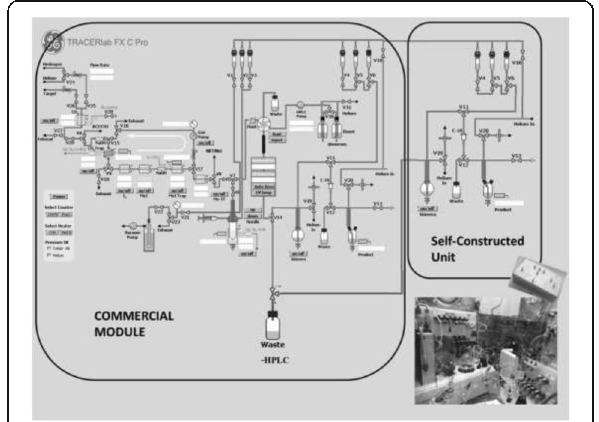
Fig. 1 (abstract OP06). Scheme of the synthesizer including the self-constructed unit for the formulation of the second tracer